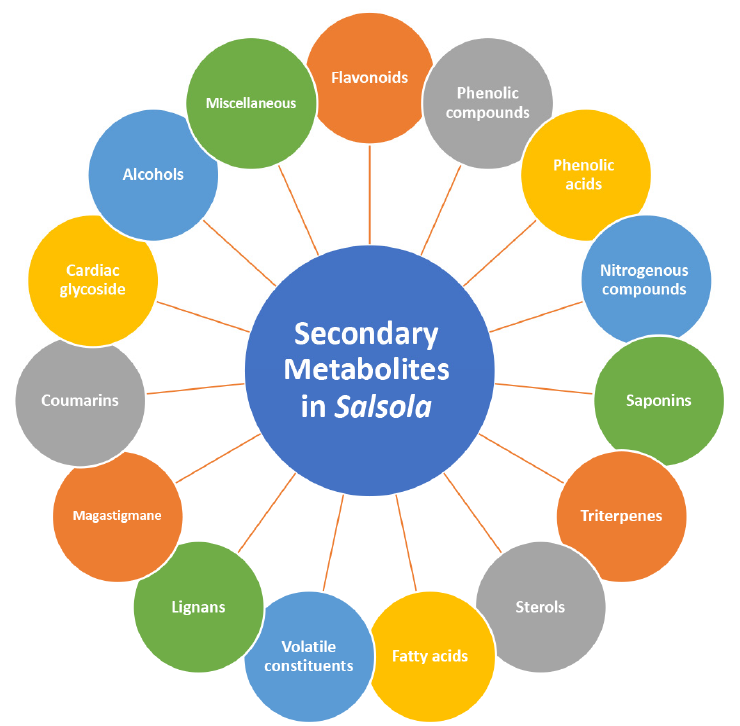
Figure 3. Different chemical constituents in genus Salsola. The structures of different secondary metabolites are presented in Figures 4–17. Mean- while, a summary of their occurrence in different Salsola species is presented in Supplemen- tary Tables